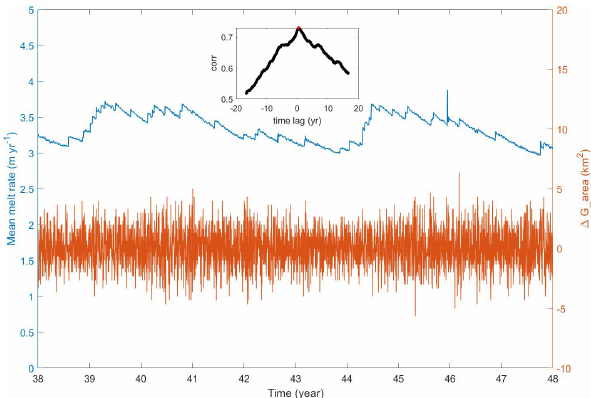
Figure A4. Mean melt rate and the moving mean changes in grounded area from the 1d outputs from year 38 to year 48 of CTRL. The correlation coefficients between the blue line and the orange line are shown in the